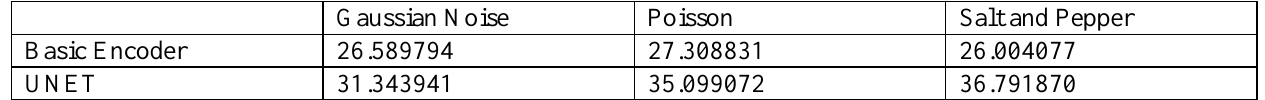
Table 2. Comparison PSNR value dealing with noise factor of 0.05